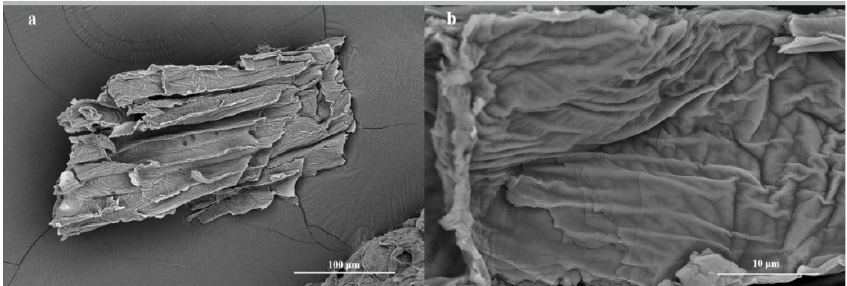
× magnification ( a ) and 10,000 × magnification ( b ). Figure 3. SEM images of original TSS at 1000x magnification (a) and 10000x magnification (b). Figure 3. SEM images of original TSS at 1000